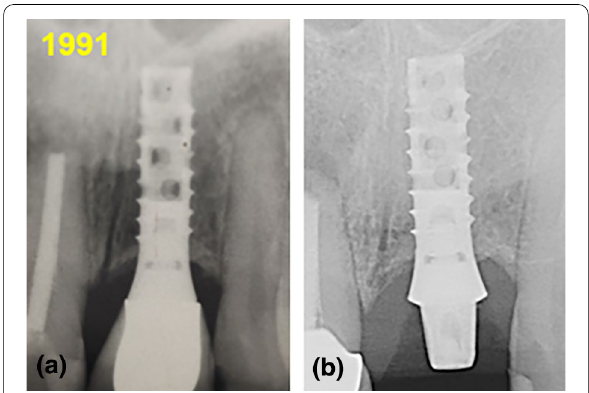
Fig. 3 Bone‑level implants with an external hex connection in a 10‑year control displaying typical circular peri‑implant bone loss (yellow lines represent the level of the implant–abutment